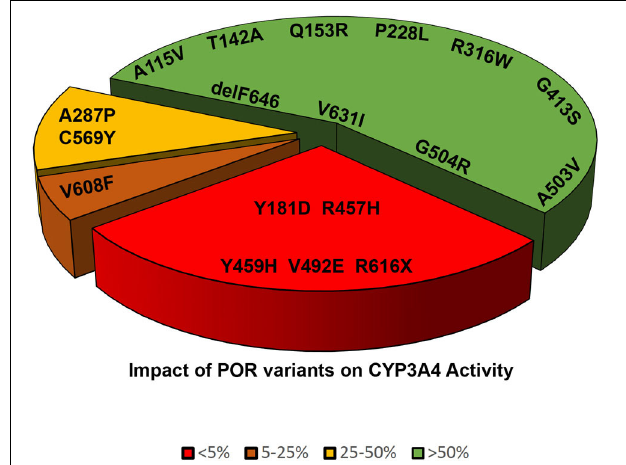
FIGURE 6 | Impact of POR variants on CYP3A4 activity. A pie chart showing the impact of POR variants on CYP3A4 activity. The variants which had < 5% of WT activity are grouped as red, variants with 5–25% of WT activity are in orange, variants with 25–50% of activity are in yellow, and variants with > 50% activity are in